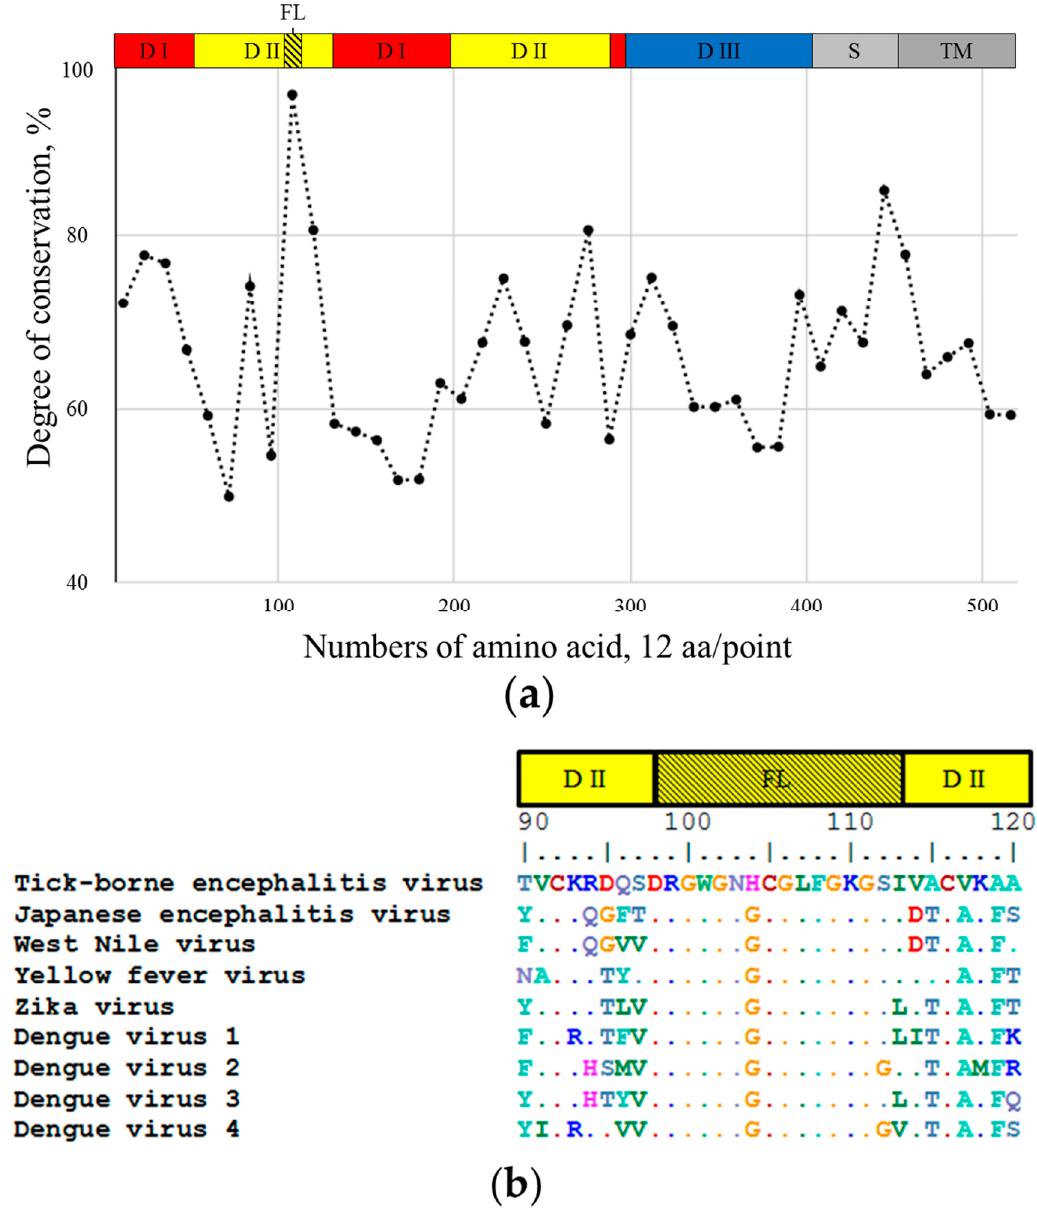
Figure 3. The identity of E proteins from 9 different flaviviruses. DI—domain I; DII—domain II; DIII—domain III; S—stem; TM—transmembrane region; FL—fusion loop. ( a )—for better perception, the sequence was divided into equal segments containing 12 aa each and the degree of conversation was calculated. The X axis displays amino acid residues of E protein, the Y axis reflects the degree of conservation of the amino acid residue in different flaviviruses (Tick-borne encephalitis virus-strain Hypr (U39292.1), Japanese encephalitis virus-strain Kamiyama 1 (S47265.1), Yellow fever virus- strain 17D Tiantan (FJ654700.1), West Nile virus-strain 956 (NC_001563.2), Zika virus-strain MR-766 (KX377335.1), Dengue virus 1-4-strain Nauru/West Pac/1974 (U88536.1), strain 16,681 ( b )—amino acid sequence alignment of the indicated viruses FL regions.